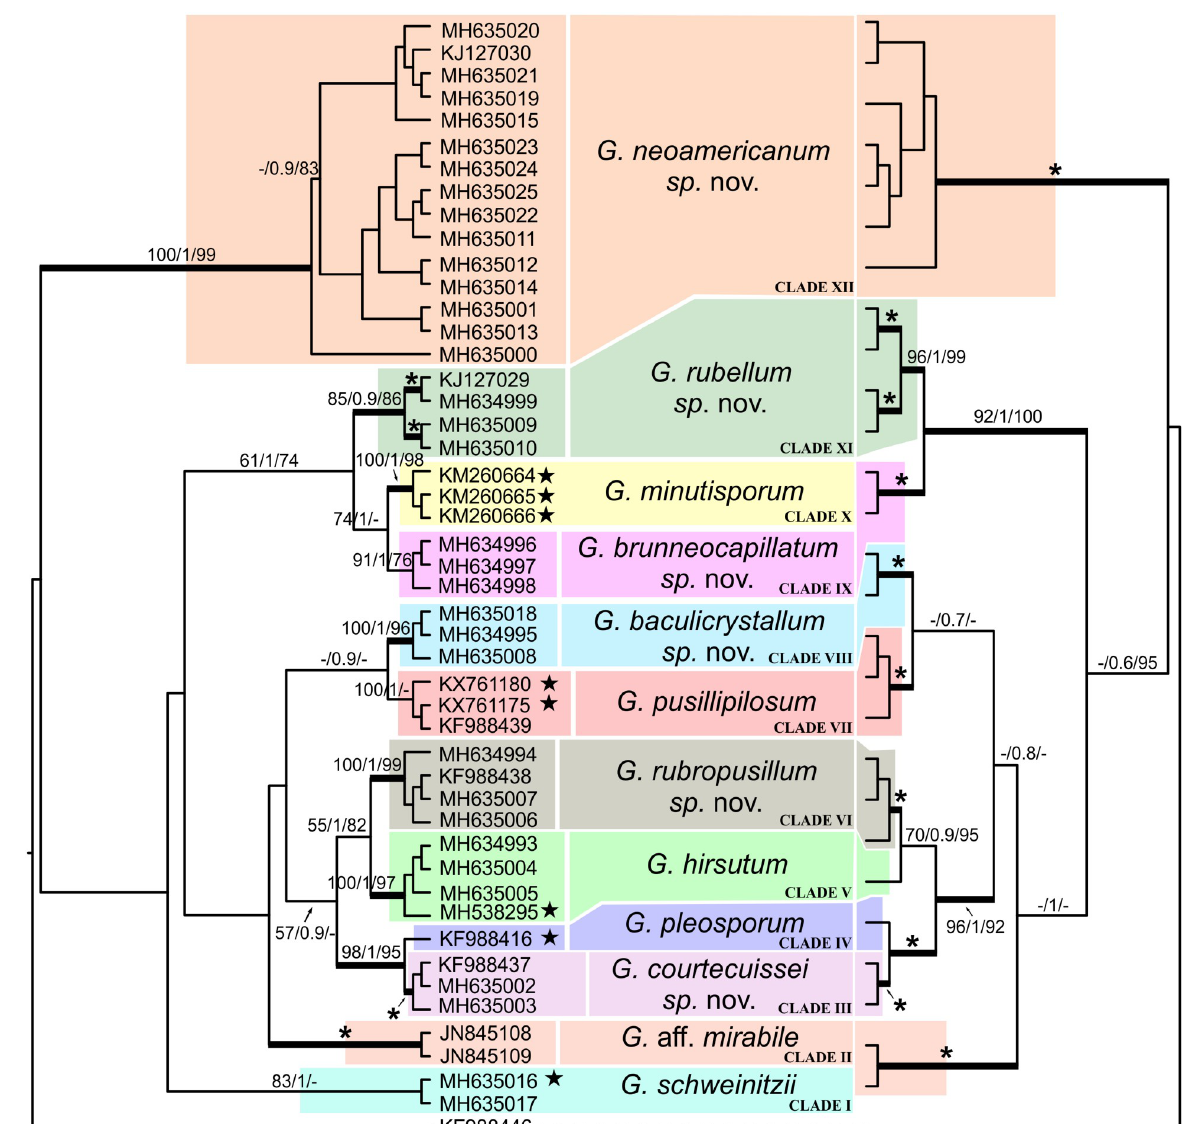
Fig 1. Bayesian trees of ITS (on the left) and ITS/LSU (on the right) nrDNA sequences of Geastrum species. Geastrum velutinum was used as out-group. Terminal branches are labeled with GenBank accession numbers. For further details, see Table 1. Numbers at the nodes indicate the Maximum Parsimony bootstrap, bootstrap values obtained from Maximum likelihood, and Posterior Probabilities from Bayesian analysis (MPbs /MLbs/ PP). Thick-lined branches are those with higher support (MPbs and MLbs higher than 85%, and PP higher than 0.85). Asterisk denotes fully supported branches in all three